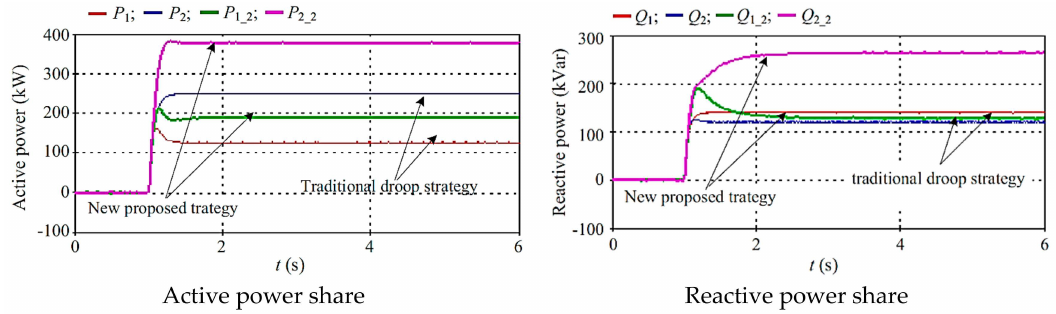
Figure 9. Comparison between the new robust droop control and the conventional droop control [80].